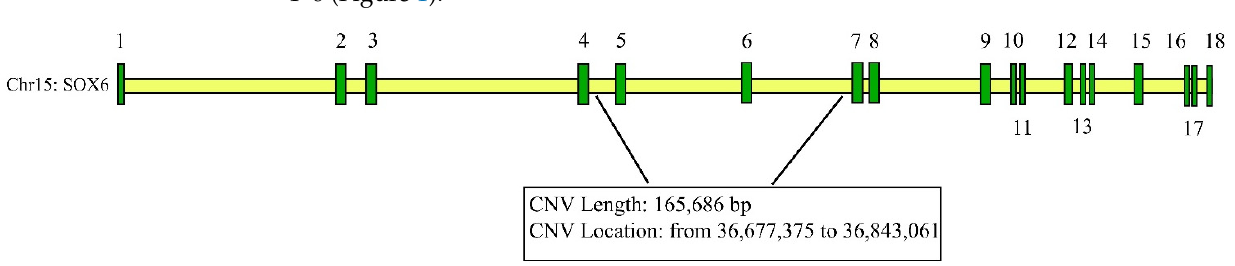
Figure 1. Information on CNVs of SOX6 genes (the numbers from 1 to 18 denote the